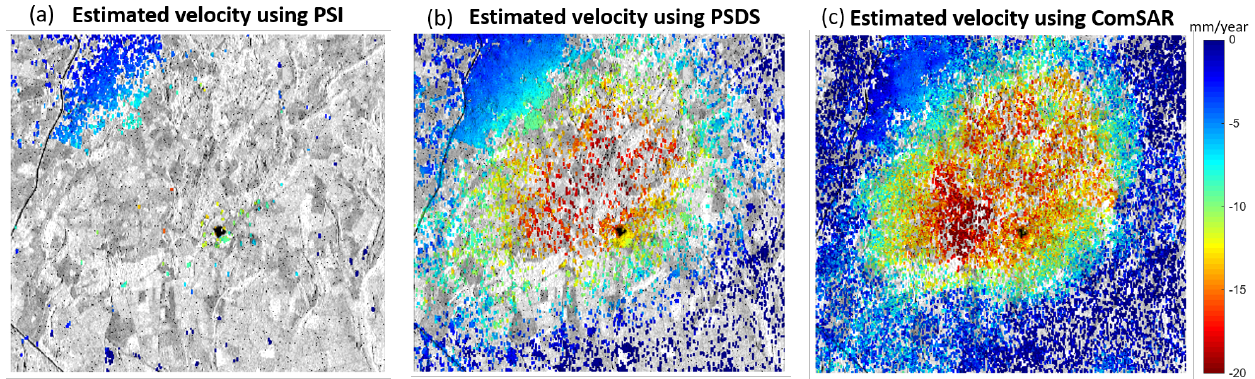
Figure 5. Estimated velocities at the Vauvert area, France.